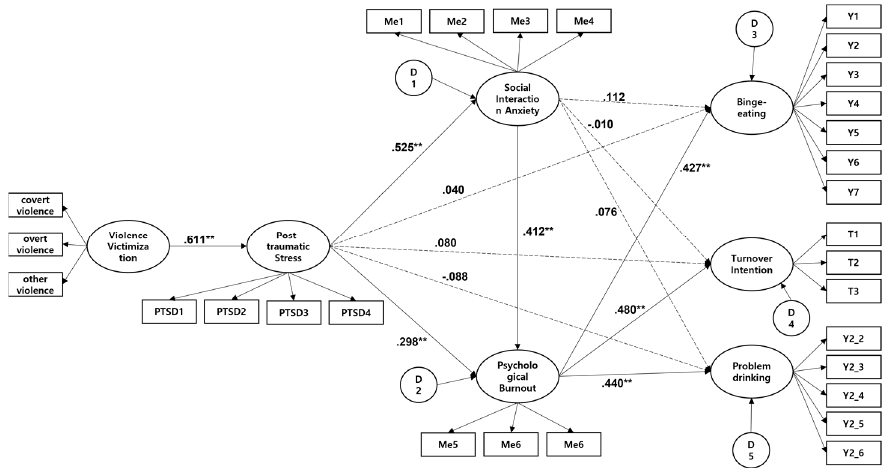
Figure 2. A structural model for PTSD from violence victimization, social interaction anxiety, psychological burnout, self-destructive behaviors, and turnover intention. Note. n = 420. ** p < 0.01.